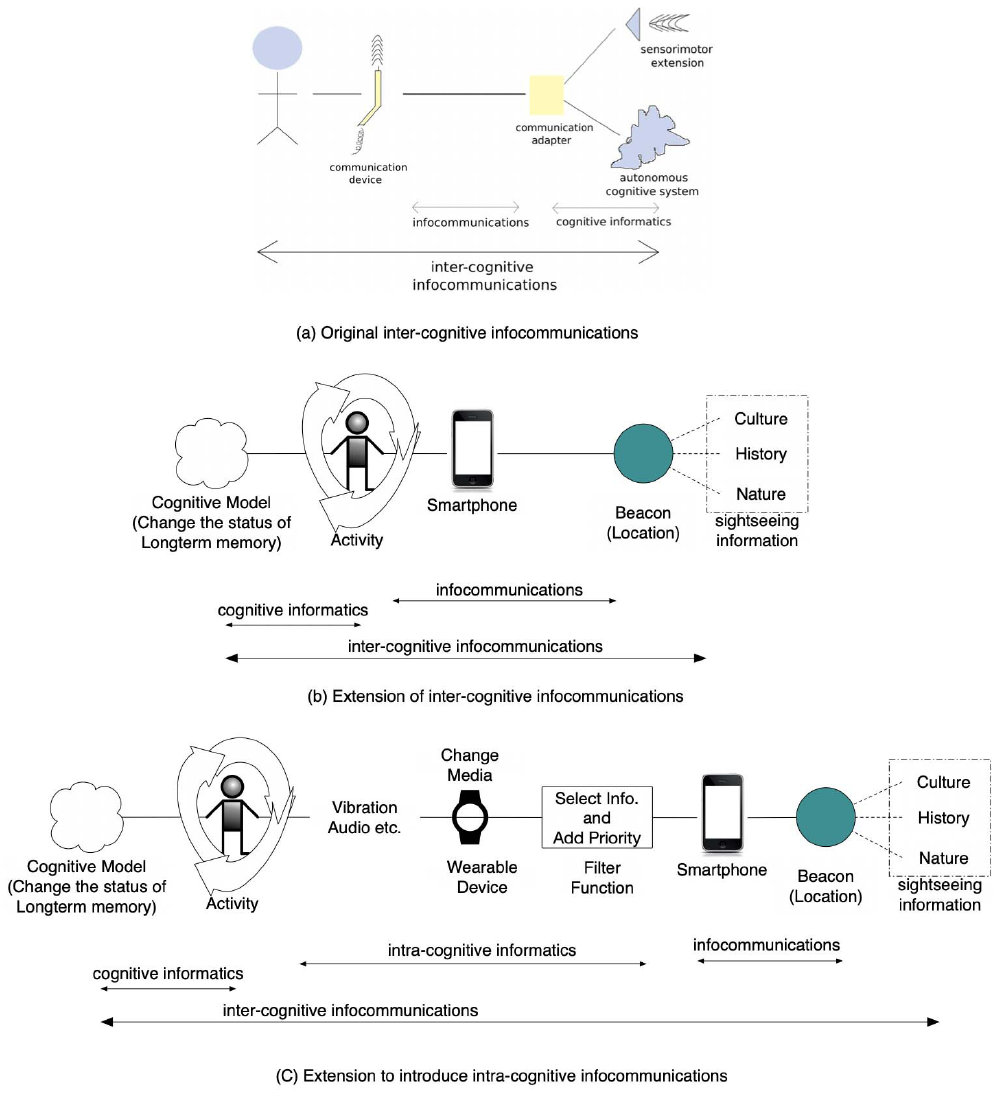
Figure 2. The relation between a cognitive model of our application and original CogInfoCom model//Extension to introduce intra-cognitive